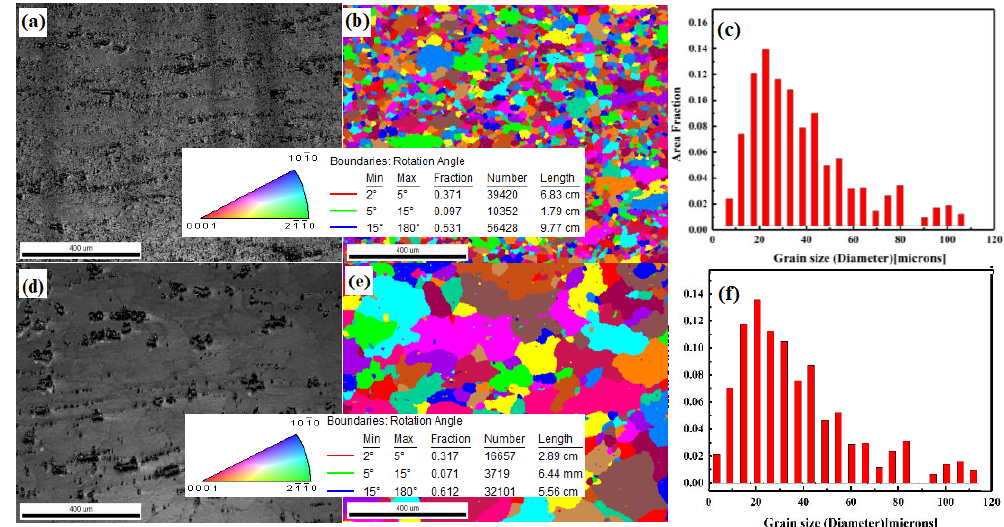
Figure 7 . EBSD images of the alloy during hot compression at the strain rate of 0.001 s −1 : ( a ) original image at 653 K; ( b ) orientation imaging at 653 K; ( c ) grain statistics at 653 K; ( d ) original image at 733 K; ( e ) orientation imaging at 733 K; ( f ) grain statistics at 733 K.